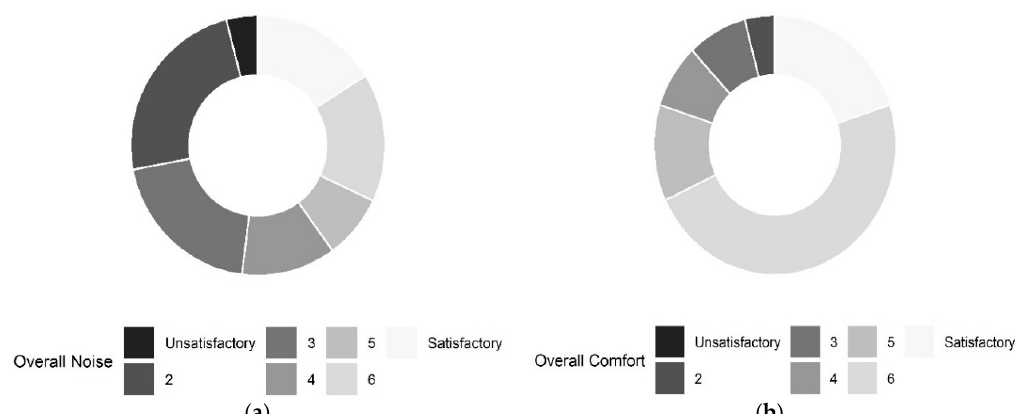
Figure 2. Level of satisfaction with: ( a ) Overall Noise; ( b ) Overall Comfort from the POE results in Stage 1 of the study.